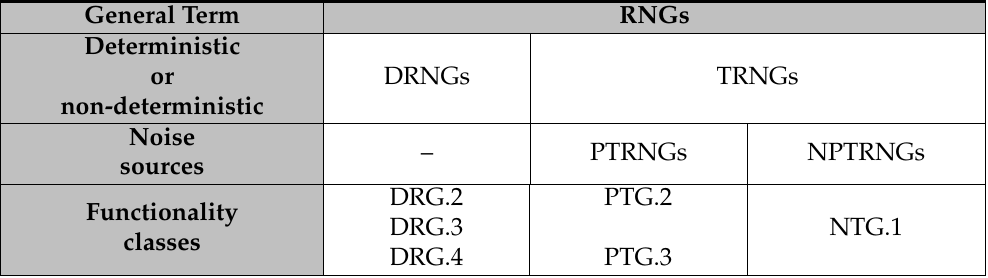
Table 2. Nomenclature and taxonomy for RNGs put out by the BSI standardisation organi-